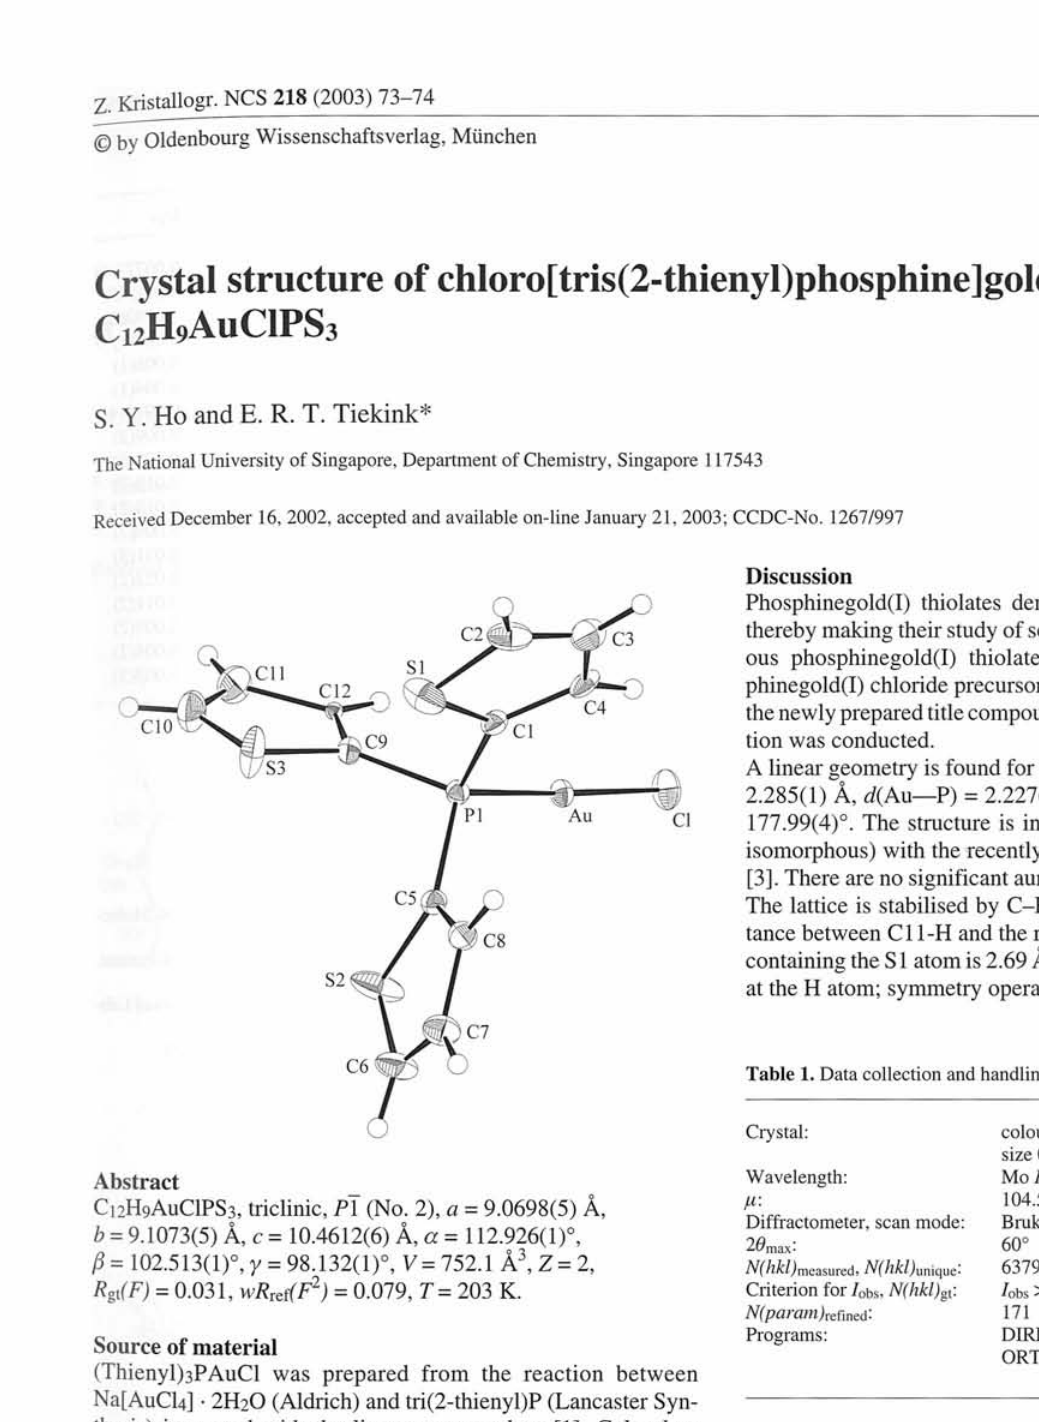
Table 2. Atomic coordinates and displacement parameters (in